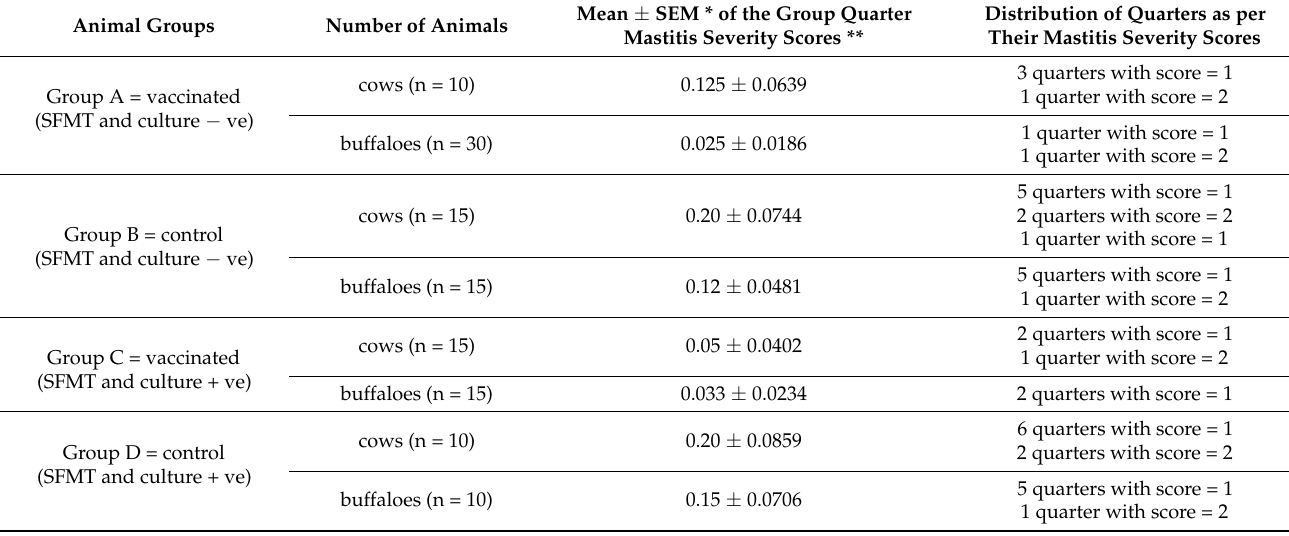
Table 3. Effects of HS–mastitis combined vaccine on the severity of mastitis.